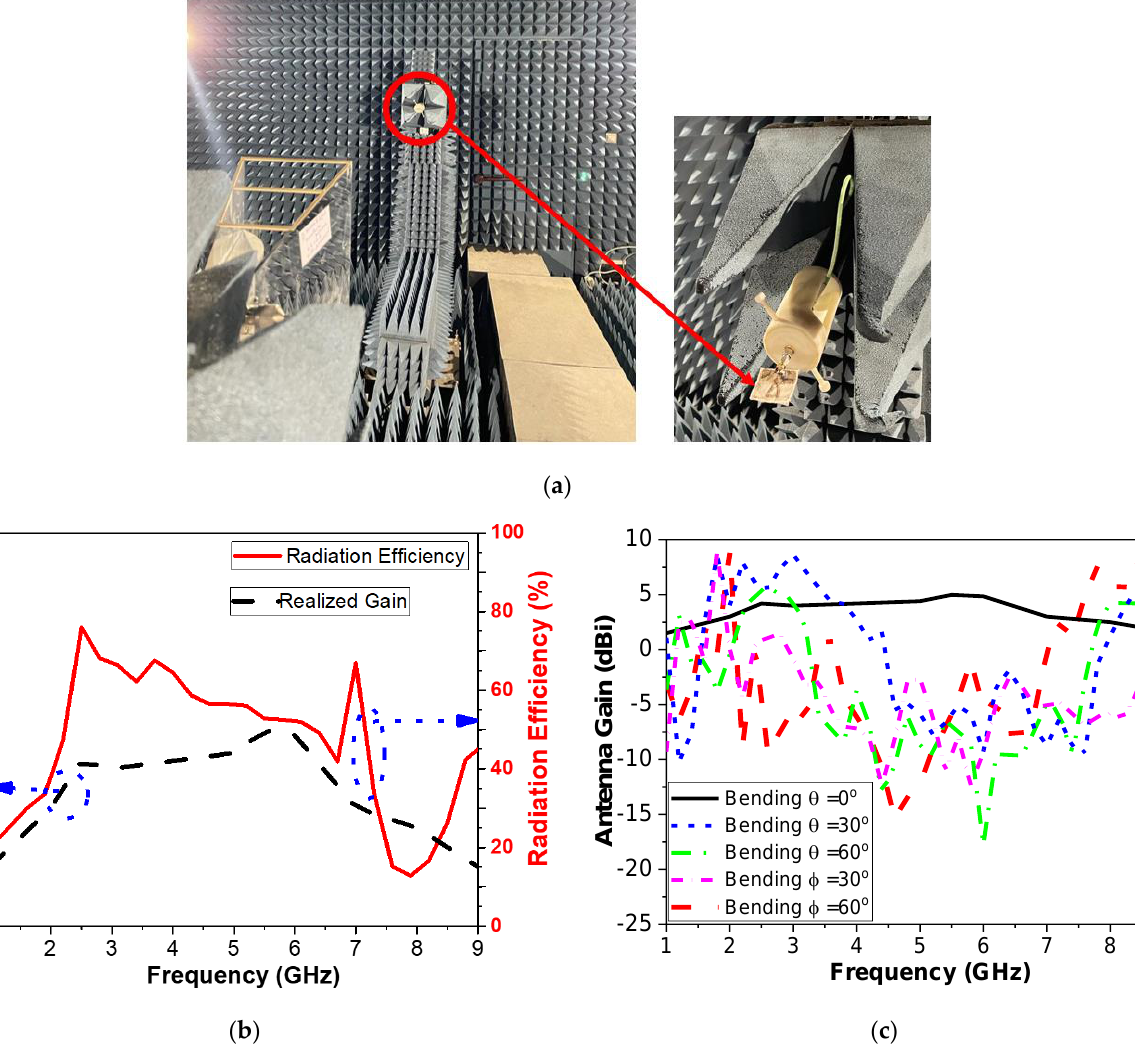
Figure 20, ( a ) Photo of the gain setup, ( b ) gain and radiation efficiency of the CPMS, and ( c ) effect of gain bending on θ axes , as in Figure